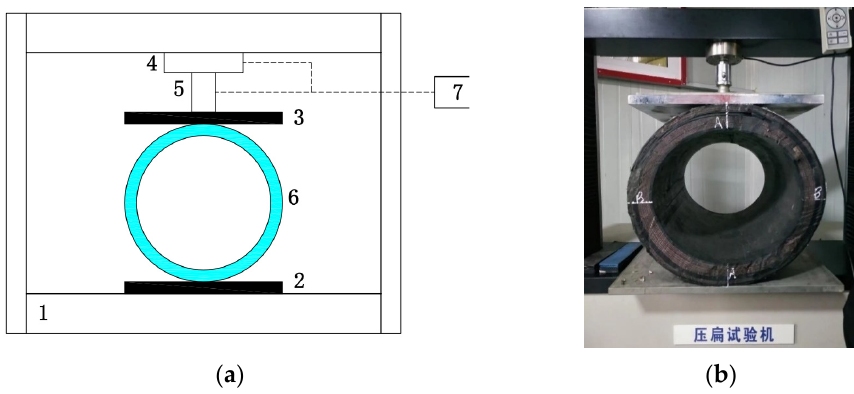
Figure 8. Set ‐ up of the test system: ( a ) sketch of the test system; ( b ) picture of the test.